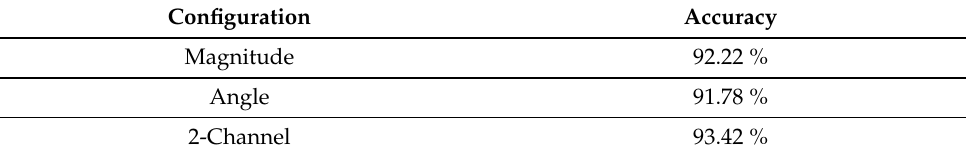
Table 3. LTS approach accuracy for magnitude angle and two-channel configurations.